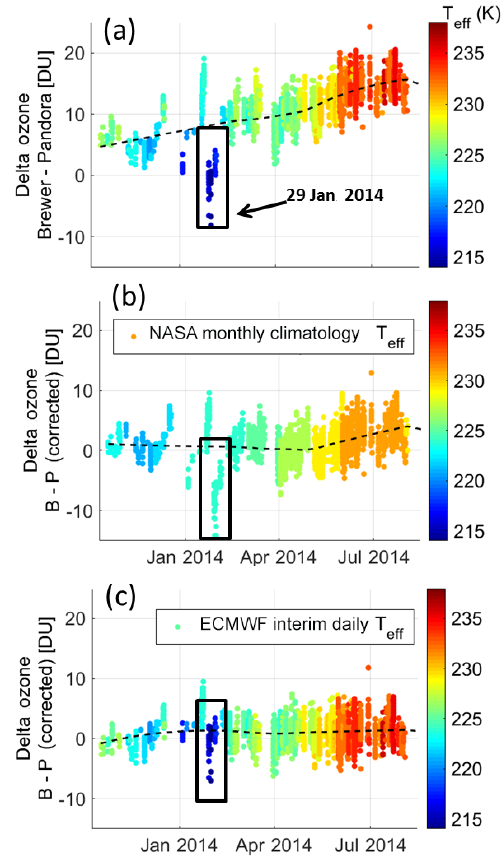
Figure 10. Time series of combined Brewer–Pandora no. 103 TCO difference colour-coded by ozone effective temperature: (a) before applying the temperature dependence correction, (b) after applying the correction using NASA monthly climatology T eff , and (c) after applying the correction using ECMWF EAR-Interim daily T eff . The sudden cooling event on 29–30 January 2014 is marked by a black box. The dashed lines are LOWESS(0.5)